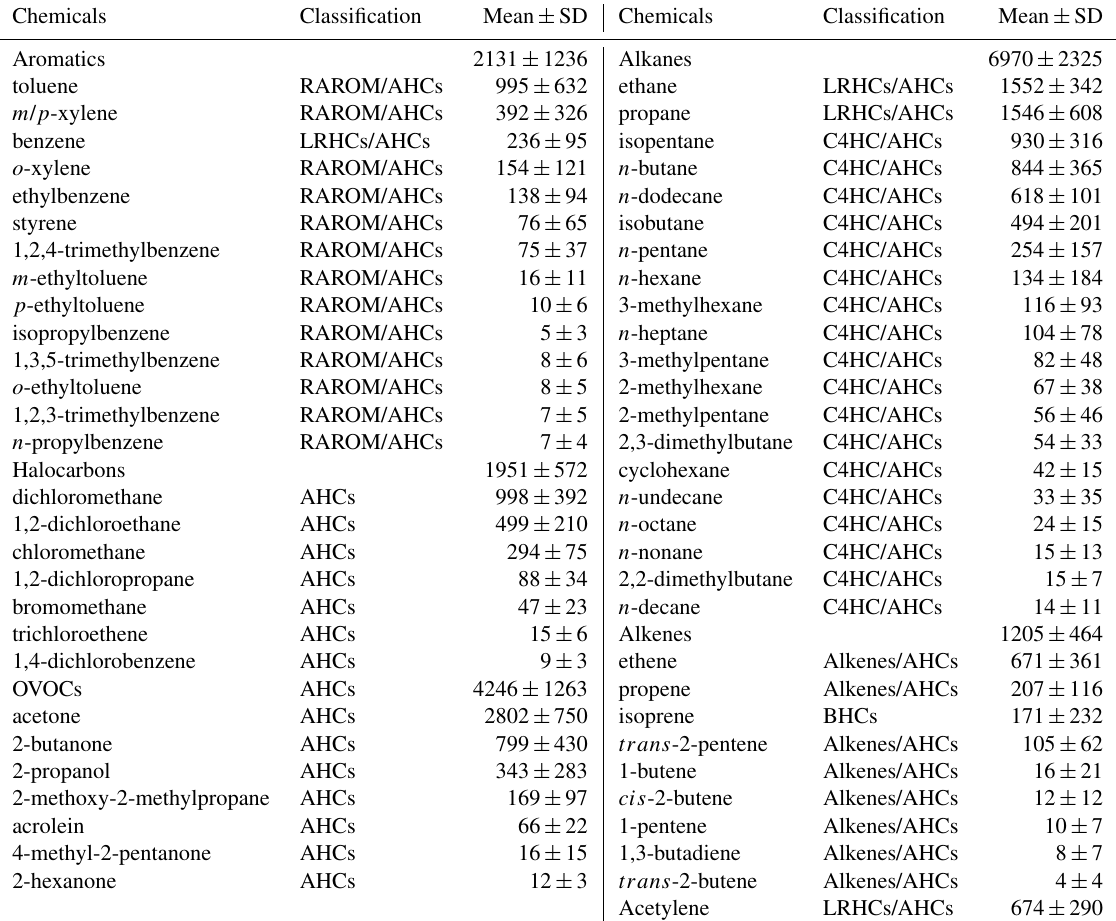
Table 3. Measured VOC concentrations during 20–29 September 2019 in Xiamen (units: pptv). The classification of VOCs was used and introduced in Sect.